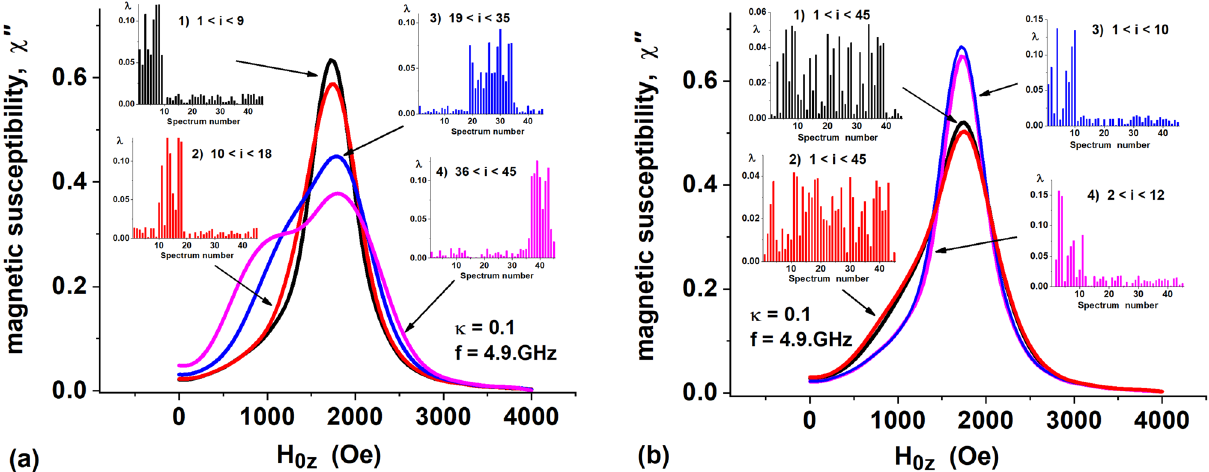
Figure 5. Composite FMR spectra constructed on the basis of basic FMR spectra presented in Supplementary Table 1. ( a ) evolution of the FMR spectrum of composite assemblies having the distribution of volume fractions λ i shown in the insets (1)–(4); ( b ) comparison of composite FMR spectra for assemblies with uniformly distributed volume fractions, cases (1), (2) and assemblies consisting mainly of quasi-spherical nanoparticles, cases (3),